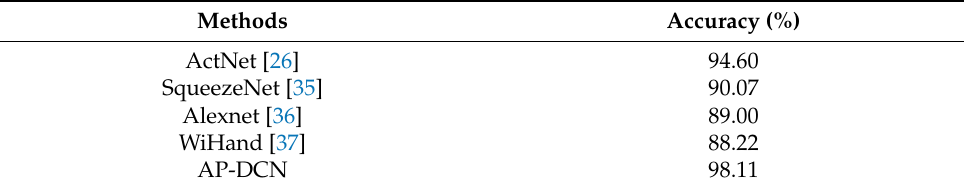
Table 6. Comparison with different recognition